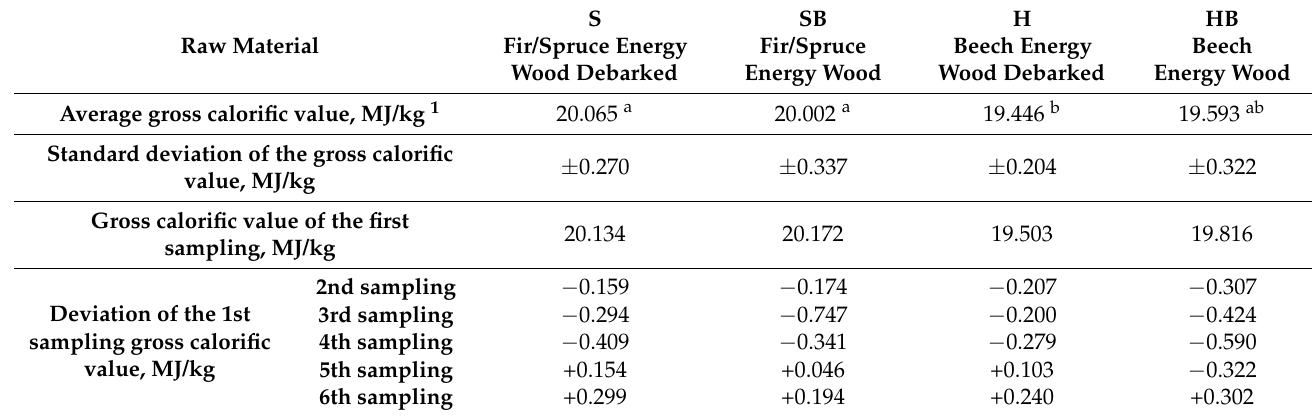
Table 3. Results of the calorimetric